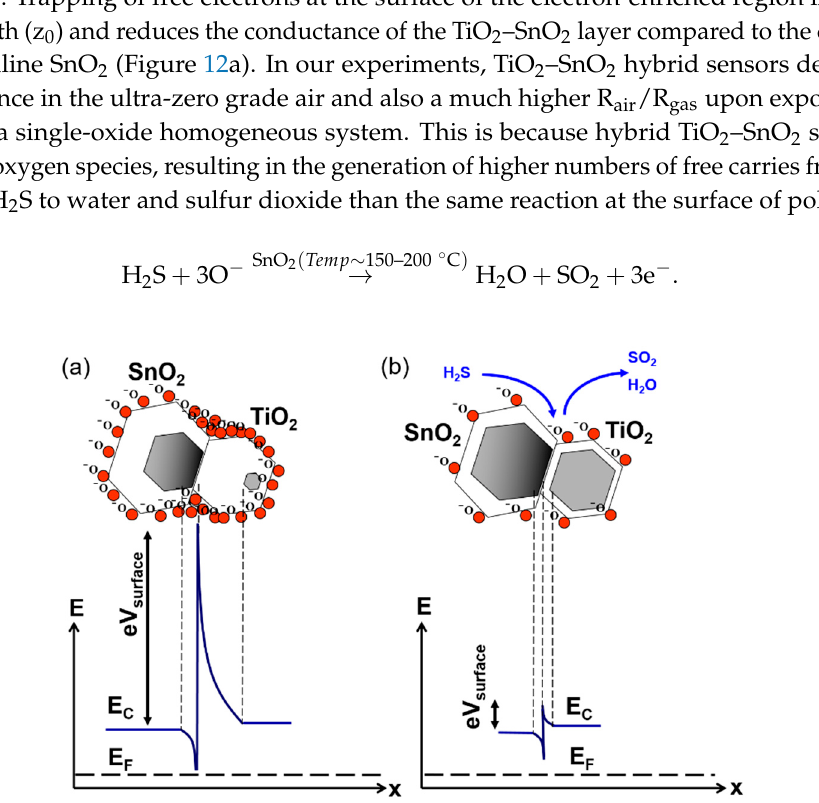
Figure 12. ( a ) Electronic grain structure of a hybrid SnO 2 /TiO 2 layer in ambient atmosphere and ( b ) upon exposure to H 2